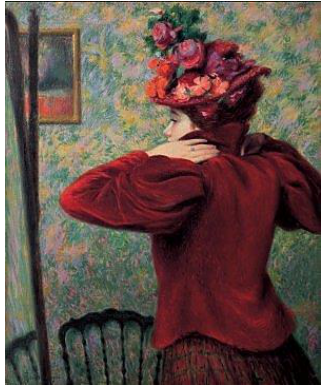
Fig. 23 The red jacket (Zandomenghi, 1895)